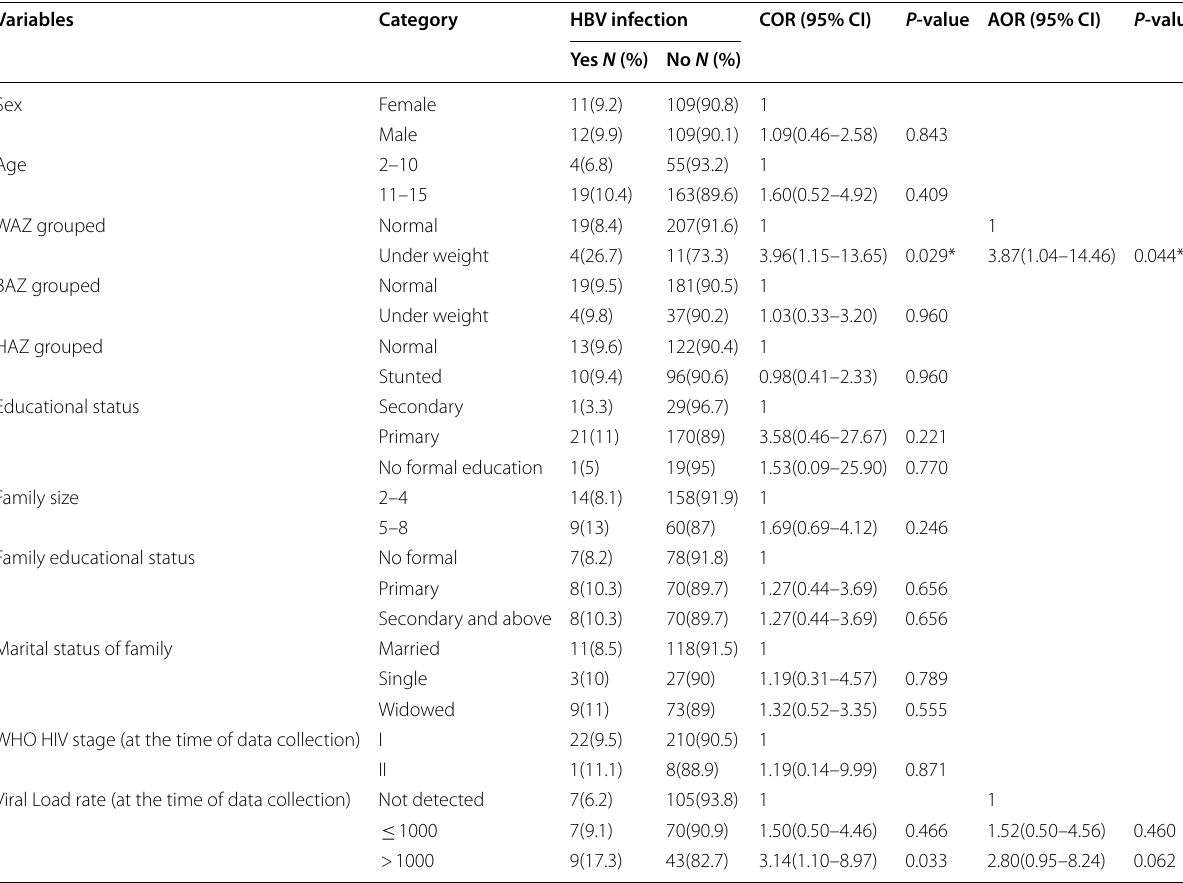
Table 2 Factors associated with HBV infection among HAART experienced children at the UoGCSH, 2020